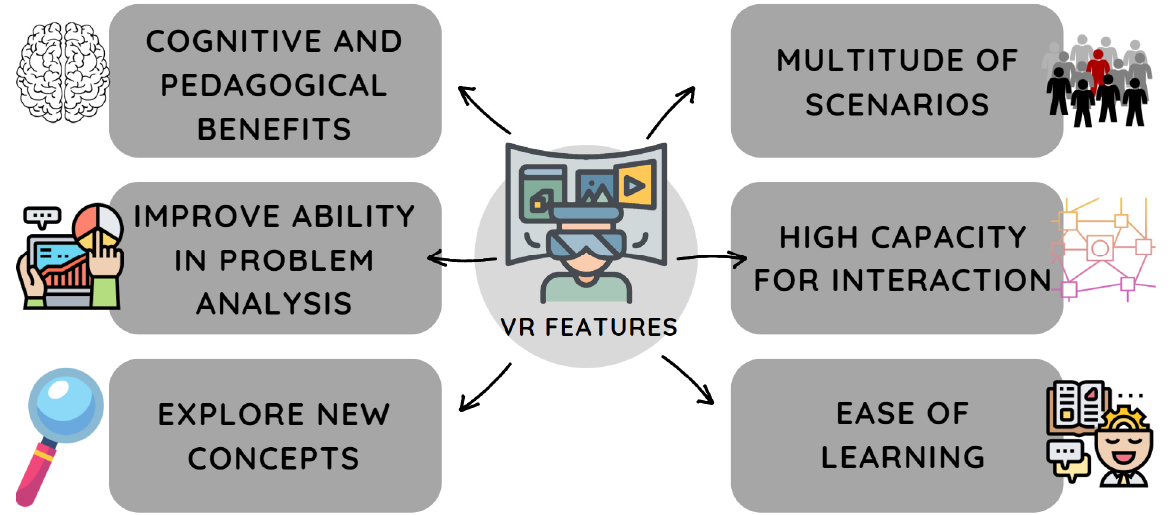
Figure 1. VR features as a didactic resource.